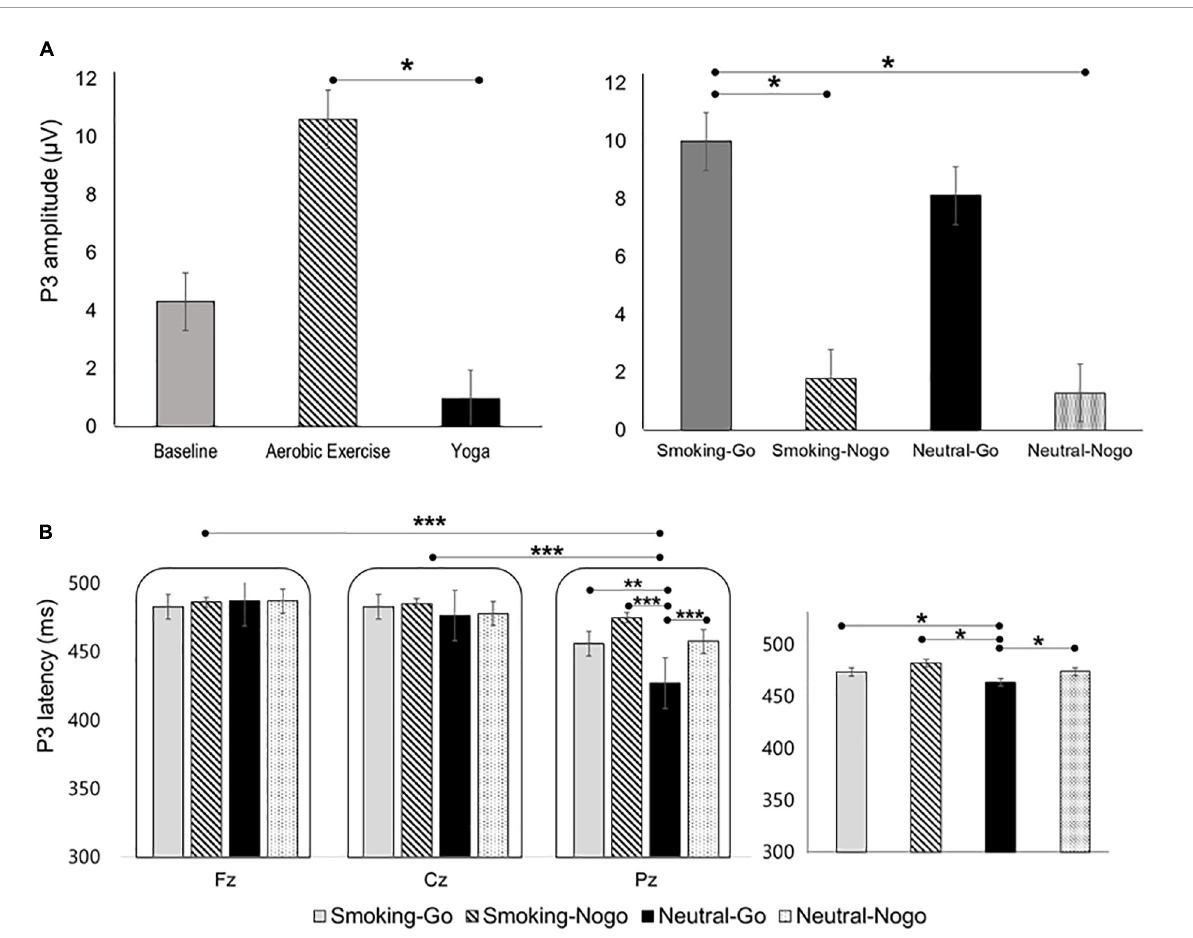
FIGURE3 Differences in (A) P3 amplitudes and (B) latencies as a function of exercise mode, stimulus condition, and region. * p < 0.05; ** p < 0.01; *** p <